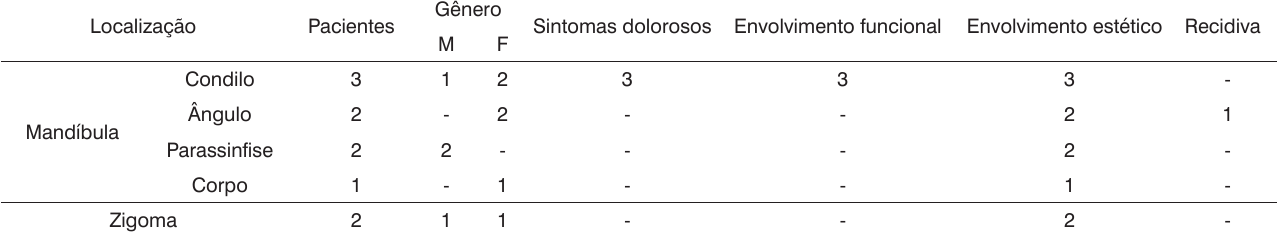
Tabela 1. Osteomas periféricos maxilofaciais: localização, gênero, sintomas, envolvimento estético e recorrência (n = 10).